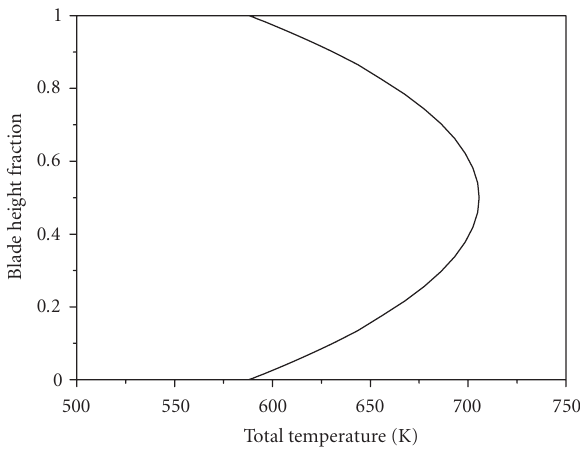
Figure 2: Turbine inlet radial temperature profile.